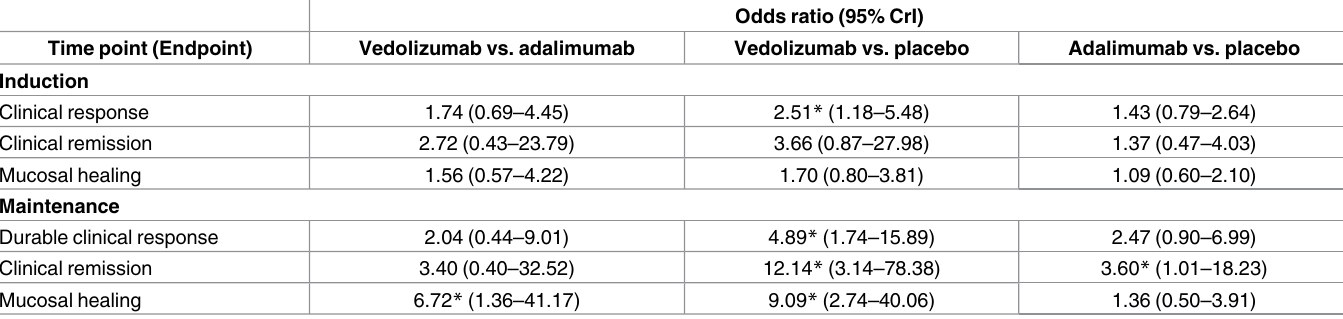
Table 3. Comparative efficacy of biological agents for induction and maintenance therapy for anti-TNF therapy-experienced